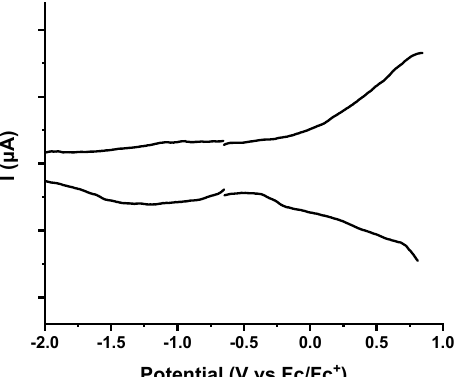
Figure A2. Square wave voltammetry (SWV) assays of exfoliated graphene recorded in N 2 -saturated dry DMF and 0.1 M TBAPF 6 . Pt wire and Pt cloth were used as reference and counter electrode respectively, while a Pt button electrode was used as the working electrode.